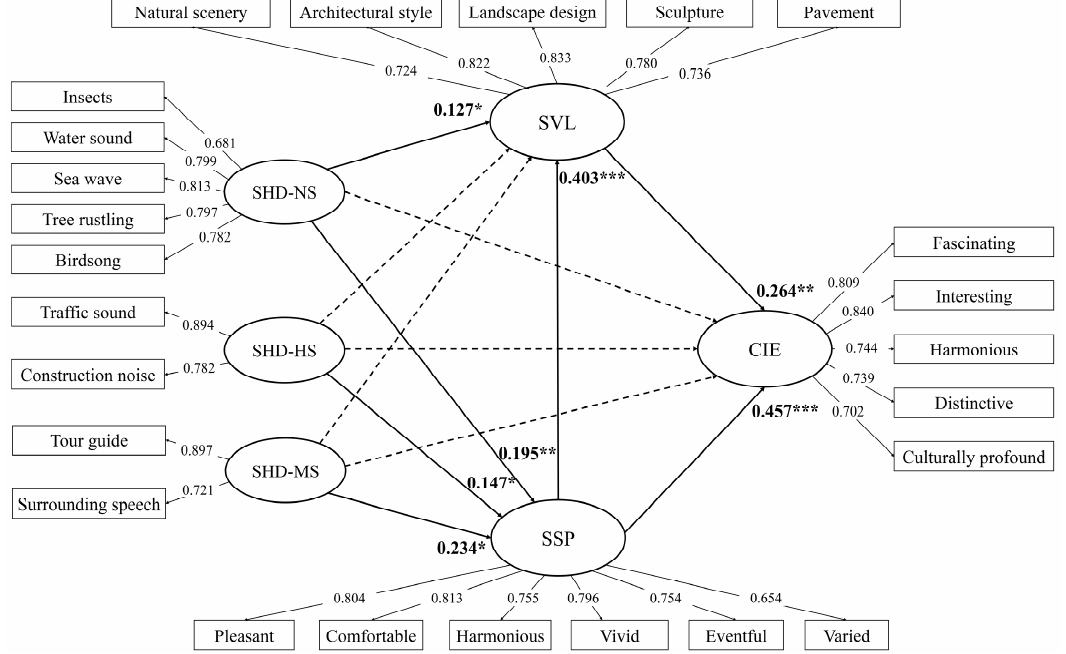
Figure 5. The modified model of the SHD influencing visiting experience in Kulangsu, SHD-NS: harmonious degree of natural sound, SHD-MS: harmonious degree of mechanical sound, SHD-HS: harmonious degree of human sound, SPE: soundscape perception, SVL: satisfaction degree of visual landscape, CIE: comprehensive impression evaluation, significant paths are marked with * ( p < 0.05), ** ( p < 0.01) or *** ( p < 0.001). Table 6. Testing of hypothesis paths in the structural equation model.